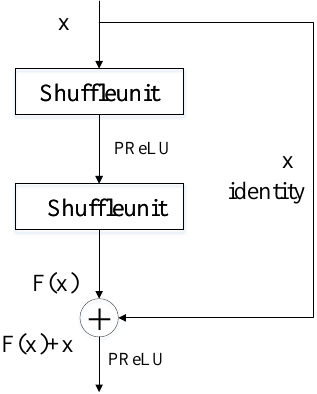
Figure 2. Structure of the SFResidual module.